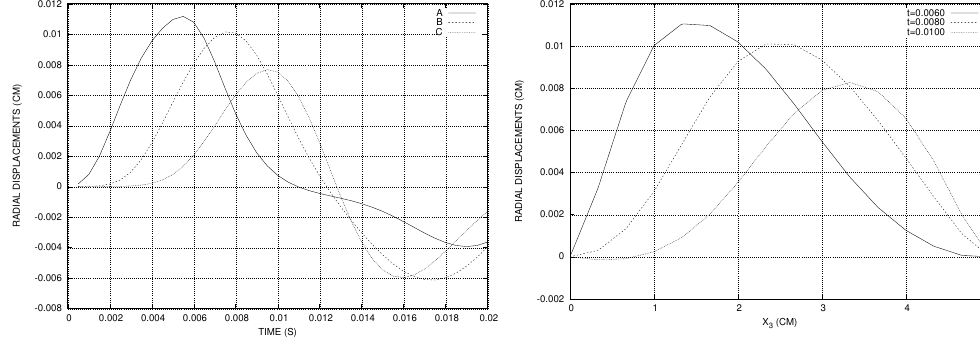
Figure 2. Constant stress at the inlet: the time history of the displacement of three points on the interface ( left ); and the radial displacement at time instants t = 0.0060, t = 0.0080, t = 0.0100 ( right